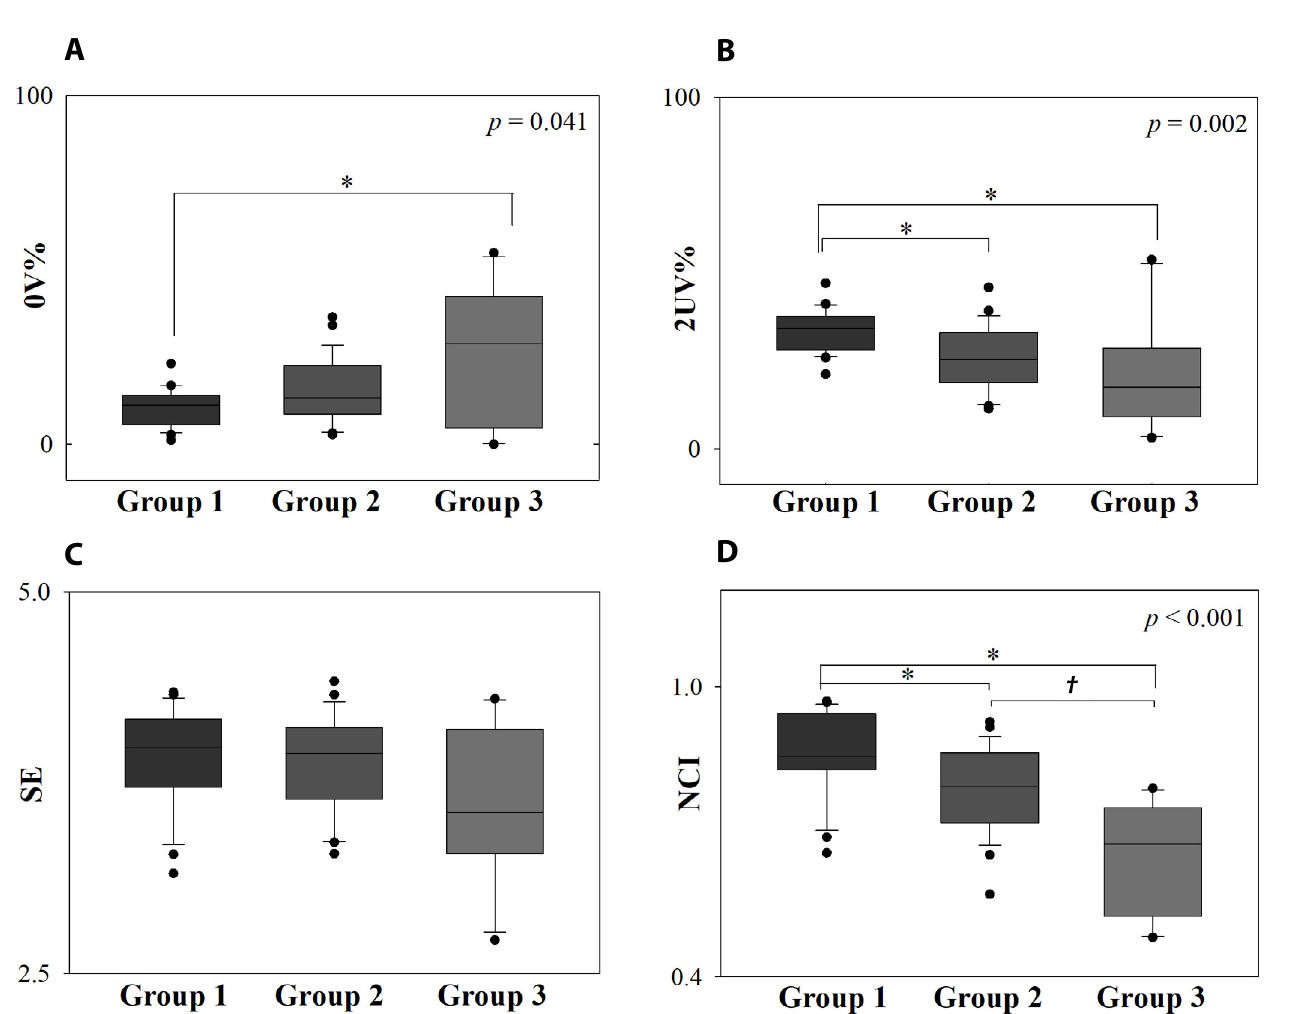
Fig. 1 – Symbolic analysis and complexity indexes. Box-and-whiskers plots of 0V% (A), 2UV% (B), Shannon entropy (SE) (C), and normalized complexity index (NCI) (D). The symbol * indicates the difference from Group 1 and the symbol † indicates the difference from Group 2. P-value is indicated in each graph when there are